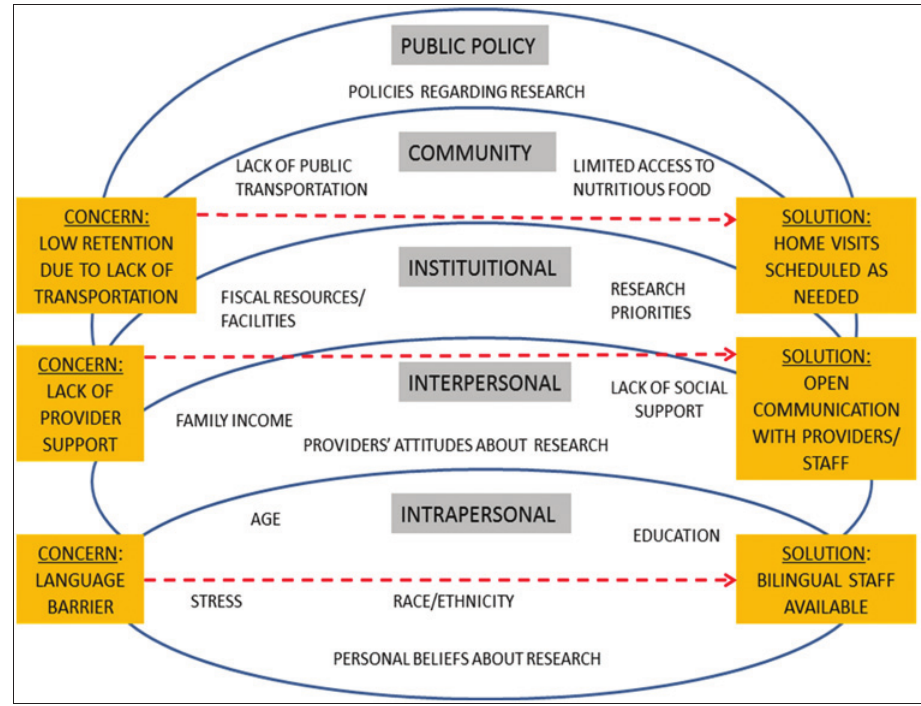
Figure 2 . Application of the Socio-Ecological Model (SEM) to enhance participation in a clinical